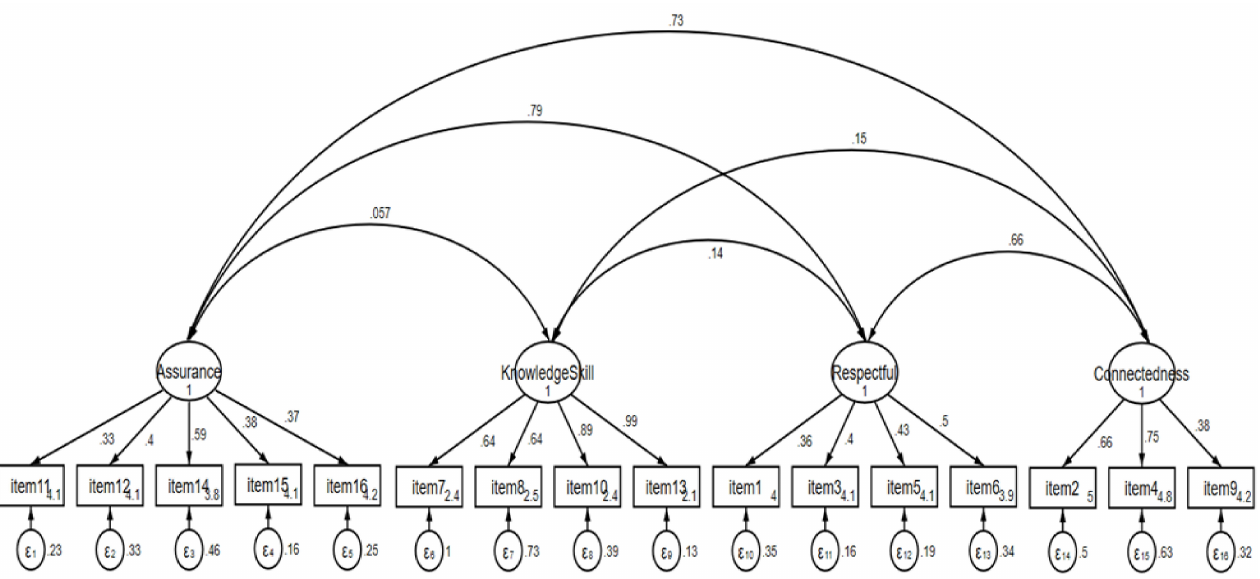
Figure 1. Scree plot of the eigenvalues for the Caring Behaviors Inventory–16.